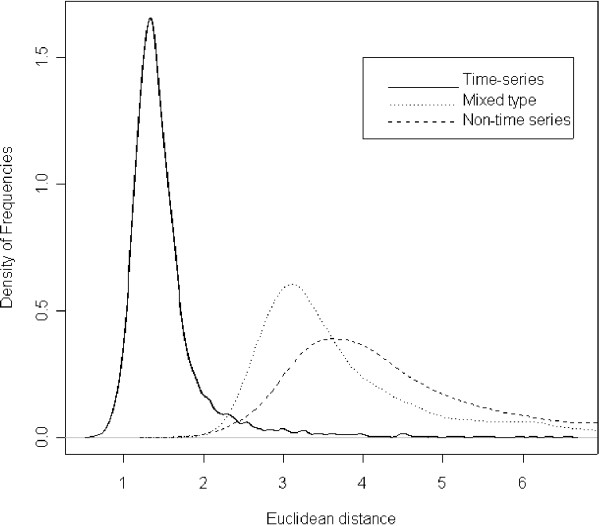
Comparison of distributions of the similarities between genes in different types of microarray data sets. The Euclidean distances were measured between a randomly selected gene and the rest of genes in each data set. The solid line, dotted line and dashed line represent for time series data, mixed data, and non-time series data respectively. The shape of the distribution implies the degree of similarities between genes in each data set.